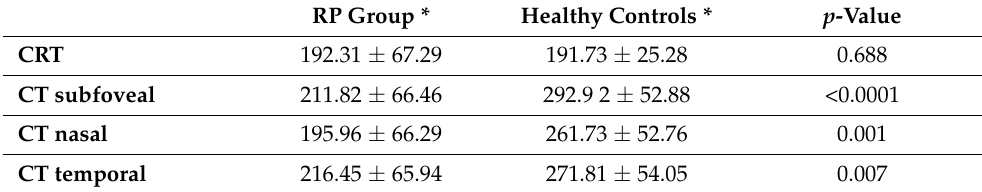
Table 2. B-Scan optical coherence tomography quantitative